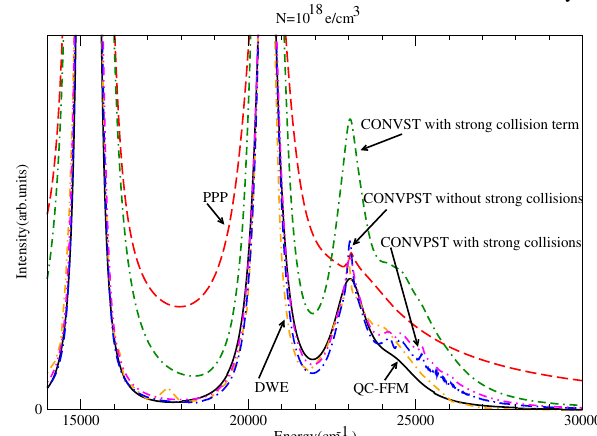
Figure 16. The series from H γ to the continuum for the intermediate density considered for DWE (dash-dotted orange) and CONVPST without (long dash-dotted blue) and with strong collisions (dash-double dotted magenta). For comparison PPP (red dashed) and QC-FFM (solid black) are also shown.